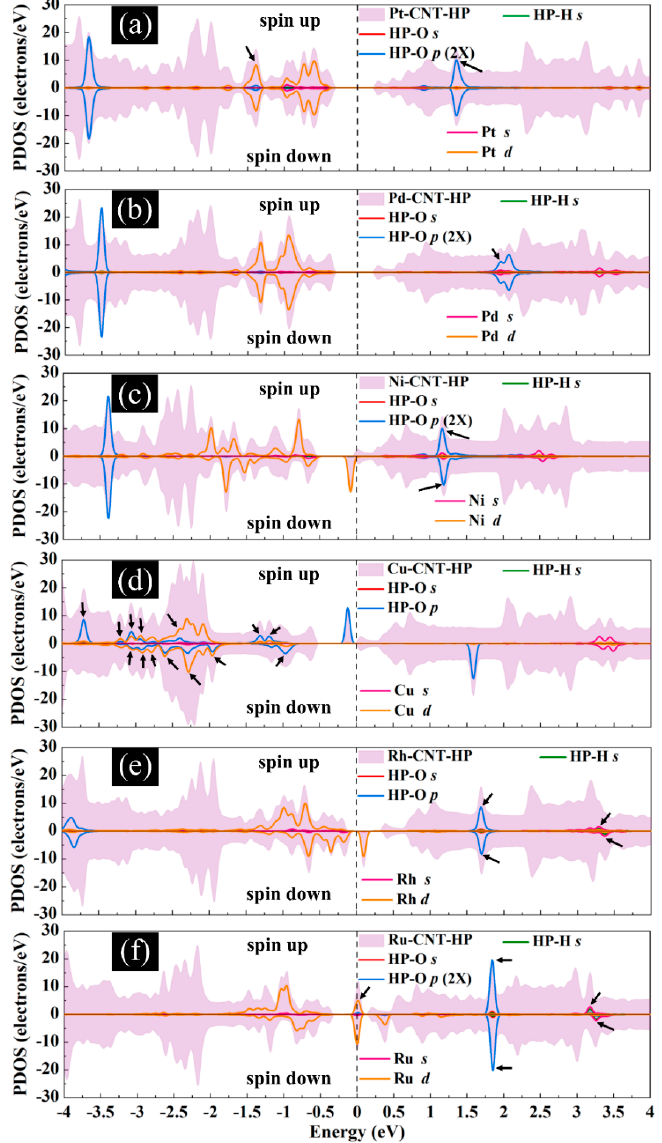
Figure 11 . Total DOS curves for H 2 O 2 adsorption on ( a ) Pt ‐ SWCNT, ( b ) Pd ‐ SWCNT, ( c ) Ni ‐ SWCNT, ( d ) Cu ‐ SWCNT, ( e ) Rh ‐ SWCNT, and ( f ) Ru ‐ SWCNT systems. PDOS of the s and p orbitals of O atoms and s orbital of H atoms in H 2 O 2 and s and d orbitals of metal atoms are also presented. The positive and negative values denote the spin ‐ up and spin ‐ down channels, respectively. The dashed lines indicate the Fermi level, which is set to zero. The black arrows present the orbital hybridization between metal atoms and the H 2 O 2 molecule